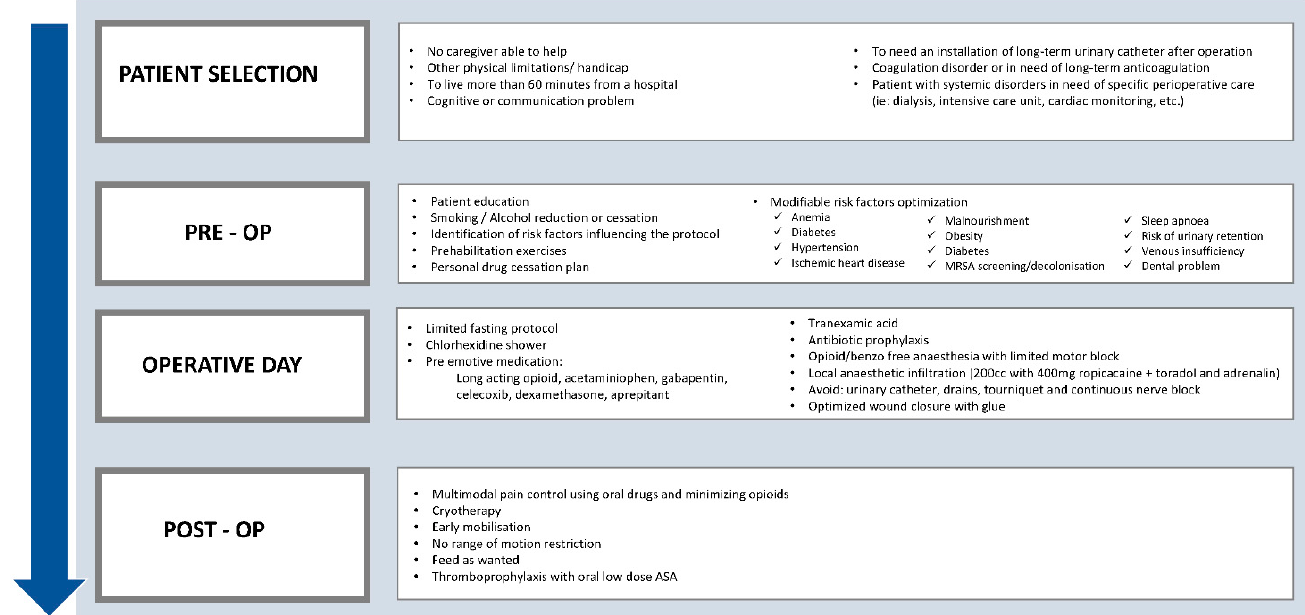
Figure 1. ERAS-outpatient Pathway.